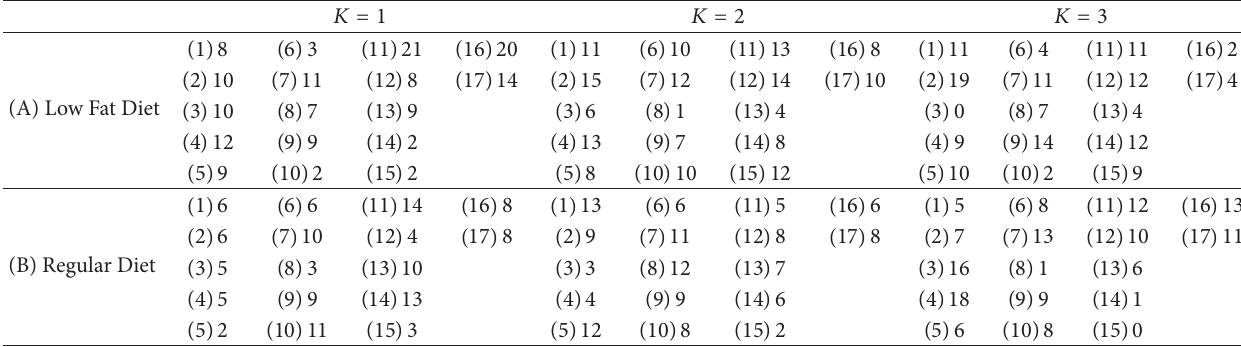
Table 2: Diet study data.